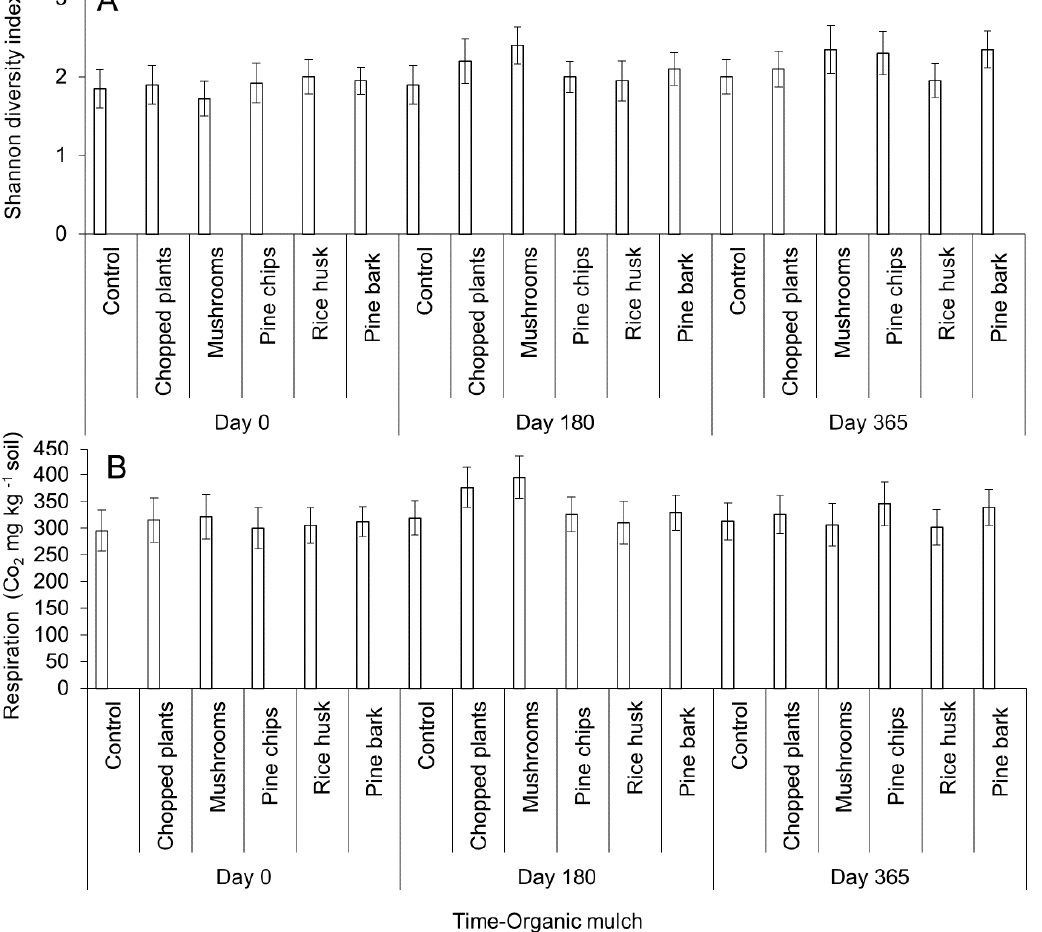
Figure 3. Microbial diversity ( A ) and microbial activity ( B ) values after the addition of organic mulch in avocado plants. Microbial diversity was calculated using the Shannon index. Microbial activity is proportional and represented as respiration values . Error bars represent the confidence intervals of the mean, validated by the Tukey mean separation test. No overlapping of the error bars indicates significant differences ( p > 0.05).